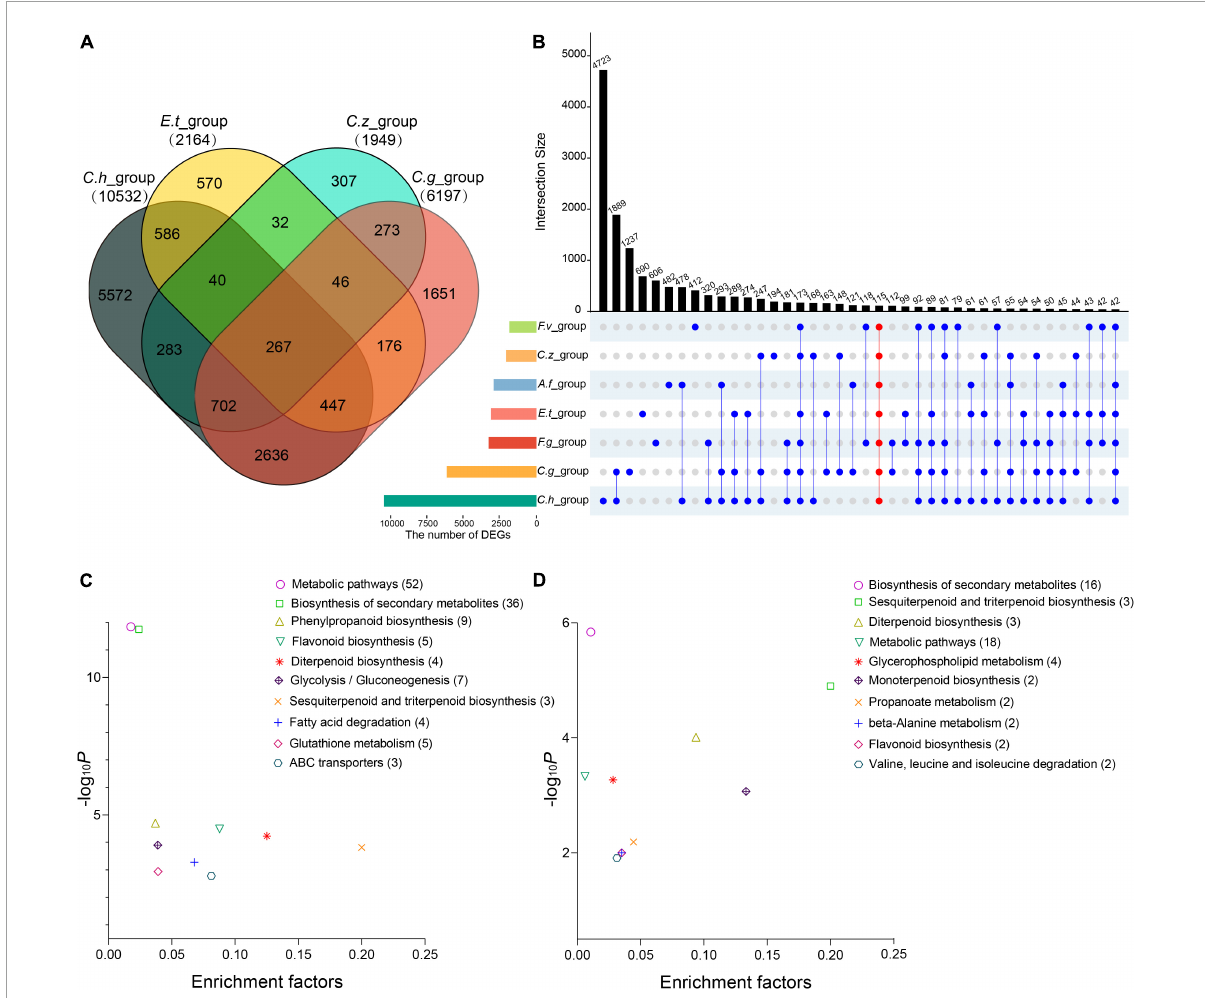
FIGURE3 Differentially expressed genes (DEGs) in the four maize leaf infection experiments and in all the seven infection experiments. (A) Venn diagram showing the overlap of DEGs among the four maize leaf infection experiments. (B) UpSet diagram showing the overlap of DEGs among all the seven infection experiments. (C) Kyoto Encyclopedia of Genes and Genomes (KEGG) analysis of the co-DEGs among the four maize leaf infection experiments. (D) KEGG analysis of the co-DEGs among all the seven infection experiments. Abscissae represents the enrichment factor of each pathway and ordinate represents -log10 (P-value). Values in parentheses represent the number of components in each